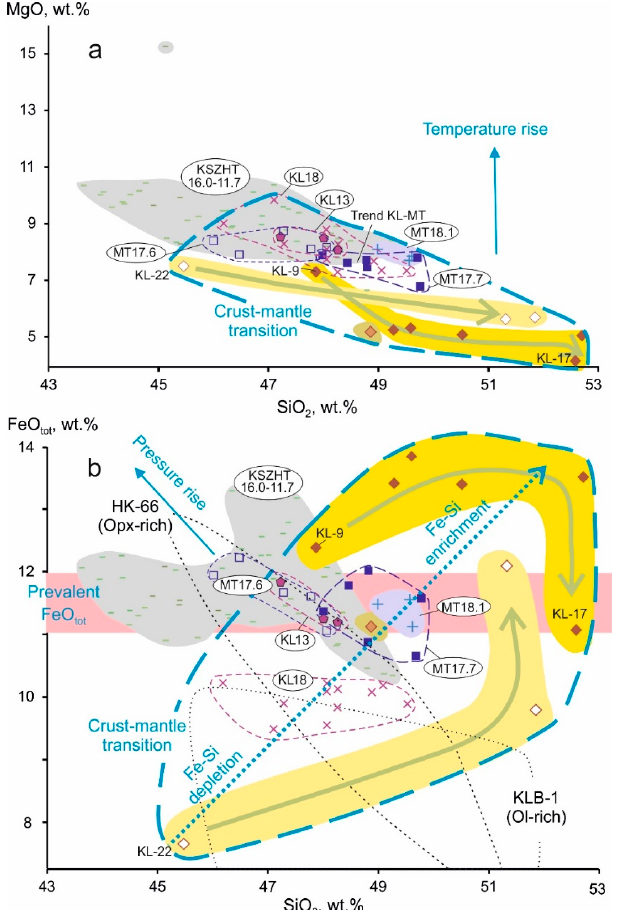
Figure 9. Comparisons of basic pseudotachylytes from the MSF and volcanic rocks from the KSZHT on MgO–SiO 2 ( a ) and FeO tot –SiO 2 ( b ) diagrams. In diagrams, measured major oxide values are plotted. Among the KSZHT rocks, specifically distinguished are those of initial and final eruptions of the Kultuk Volcano in the MSF about 18 and 13 Ma (designated as KL18 and KL13, respectively), three phases of the Meteo Volcano (18.1, 17.7, and 17.6 Ma, designated as MT18.1, MT17.7, and MT17.6, respectively) that is the farthest from the MSF, and time-intermediate eruptions of the Karerny, Sukhoi, and Shirokiy volcanoes (designated as KSZHT 16.0–11.7) that arrange along a west-east line occurred between the Kultuk and Meteo volcanoes (Figure 1). Symbols of the MSF low- and moderate-Ti basic pseudotachylytes are as in Figure 4. Shown for comparisons are also data fields of melts experimentally generated from the lherzolites enriched in olivine (KLB-1) and orthopyroxene (HK-66) with pressure rise [81].